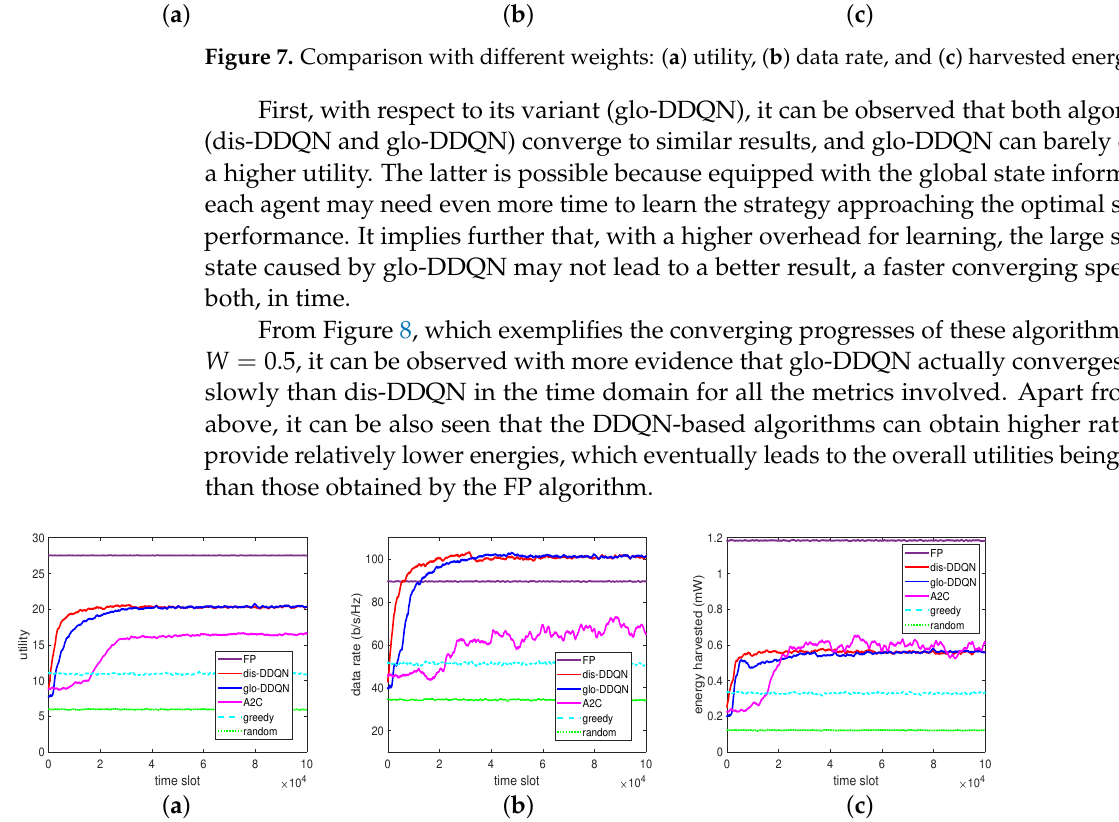
Figure 8. Comparison on convergence: ( a ) utility, ( b ) data rate, and ( c ) harvested energy. Second, with respect to A2C, which represents a state-of-the-art single-agent